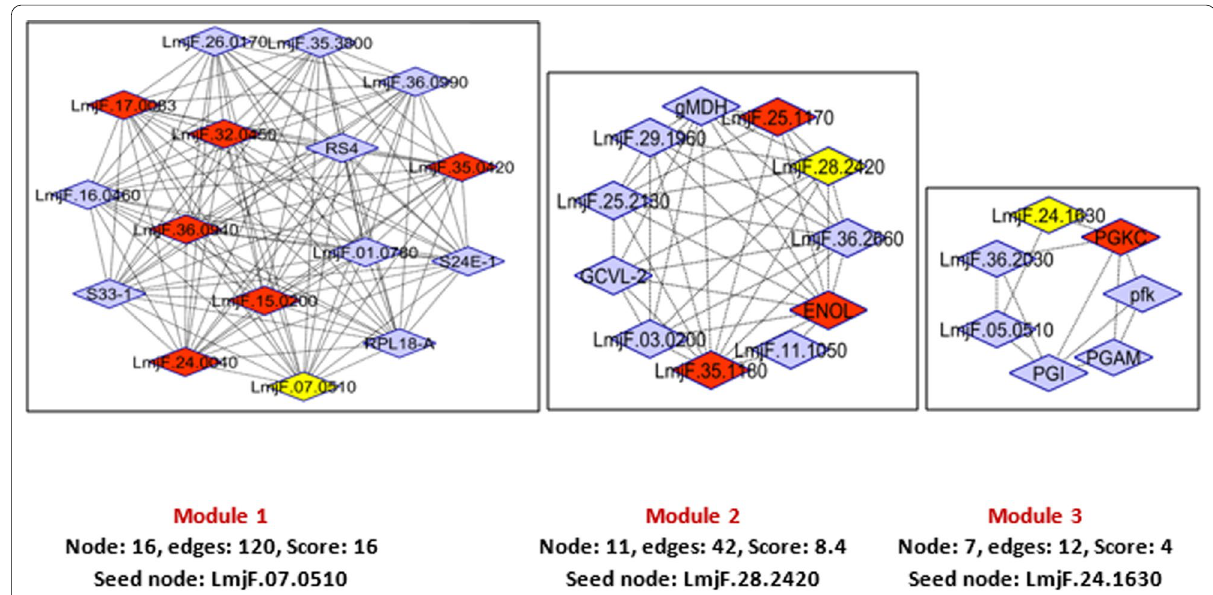
Fig. 5 The modules of whole PPI network. The hub proteins of our analyses are presented in modules 1, 2 and 3 that are shown in orange color. Seed nodes in each module are also shown by yellow